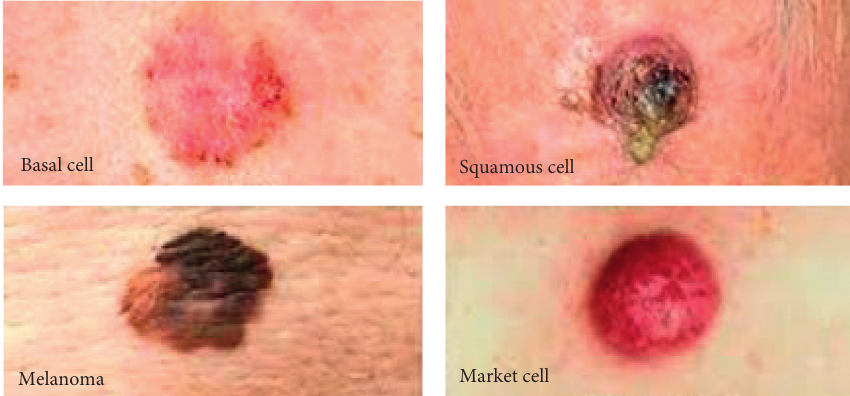
Figure 2: Effects of acquisition devise in skin detection.